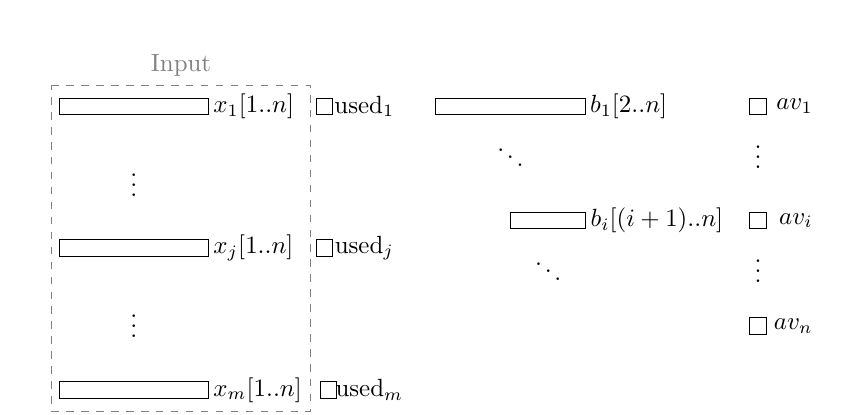
Figure 7: Abstract memory layout. Input is the x j [1 ..n ], all other qubits are set to